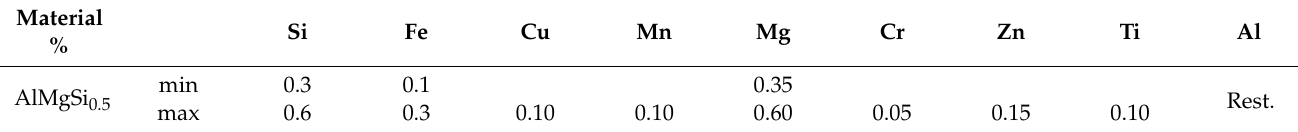
Table 1. Chemical composition of aluminium alloy AlMgSi 0.5 (EN AW